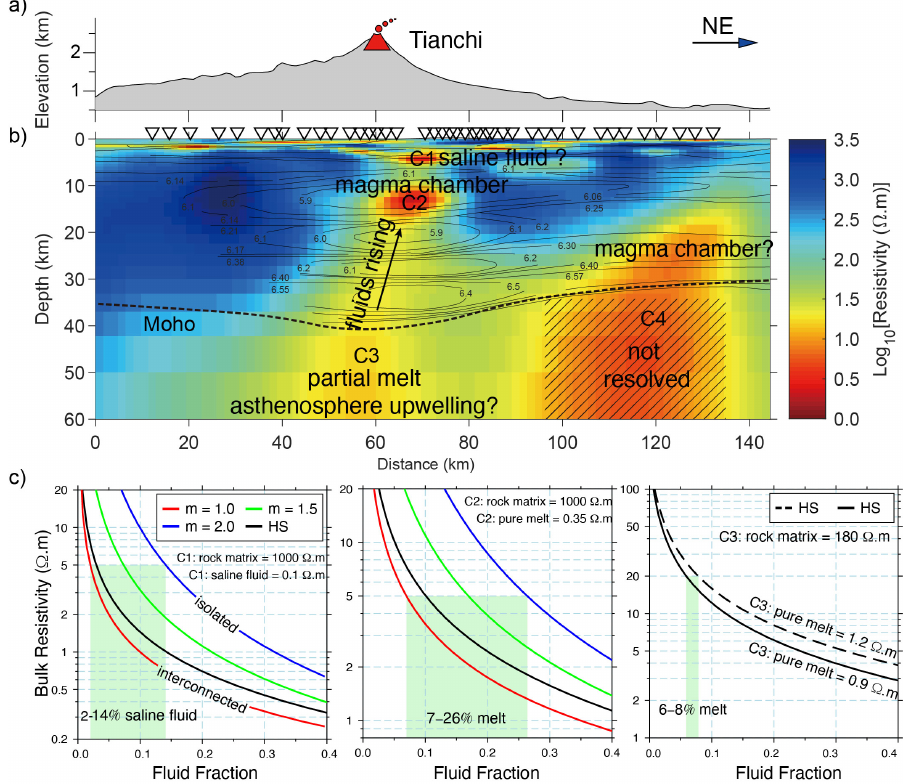
Figure 7. ( a – c ) MT resistivity model of Changbaishan-Tianchi volcano system and its implications for fluid fraction modified after Yang et al.